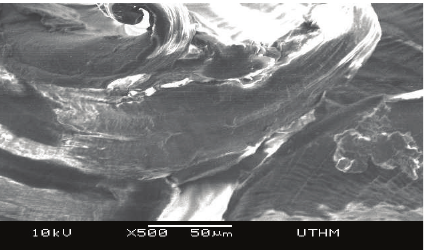
Figure 6: SEM image of fractured neat LDPE at 500x